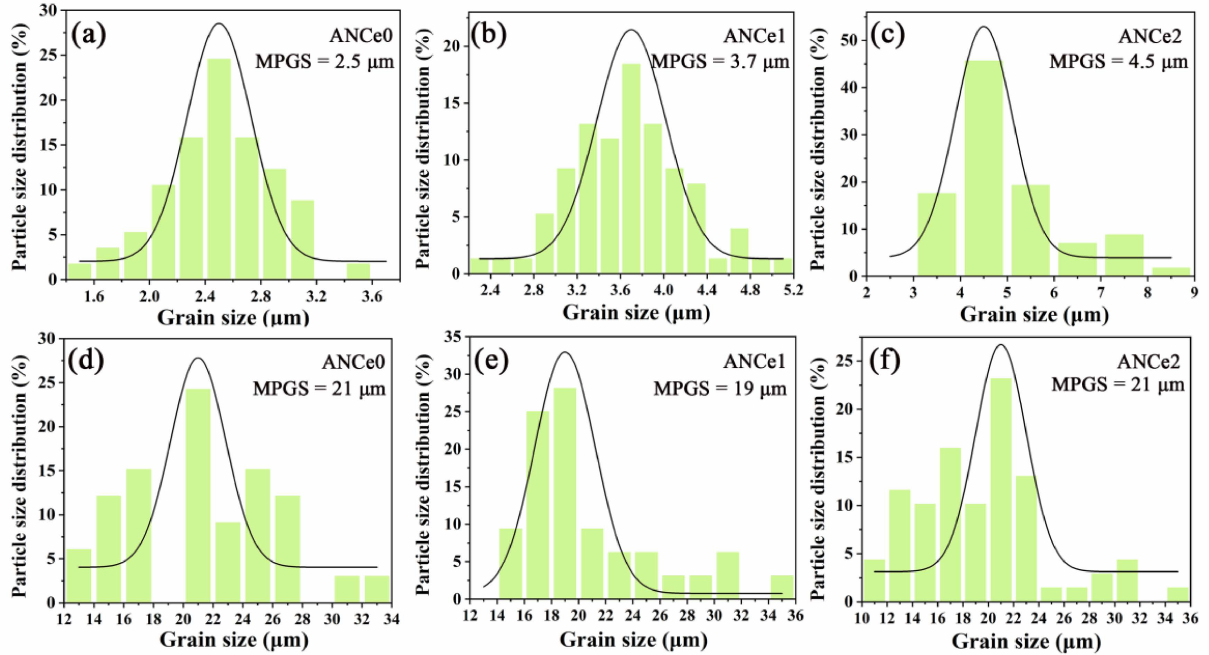
Figure 3. Grain size distribution of ANCe x ceramics. Grain size distribution of small particles of